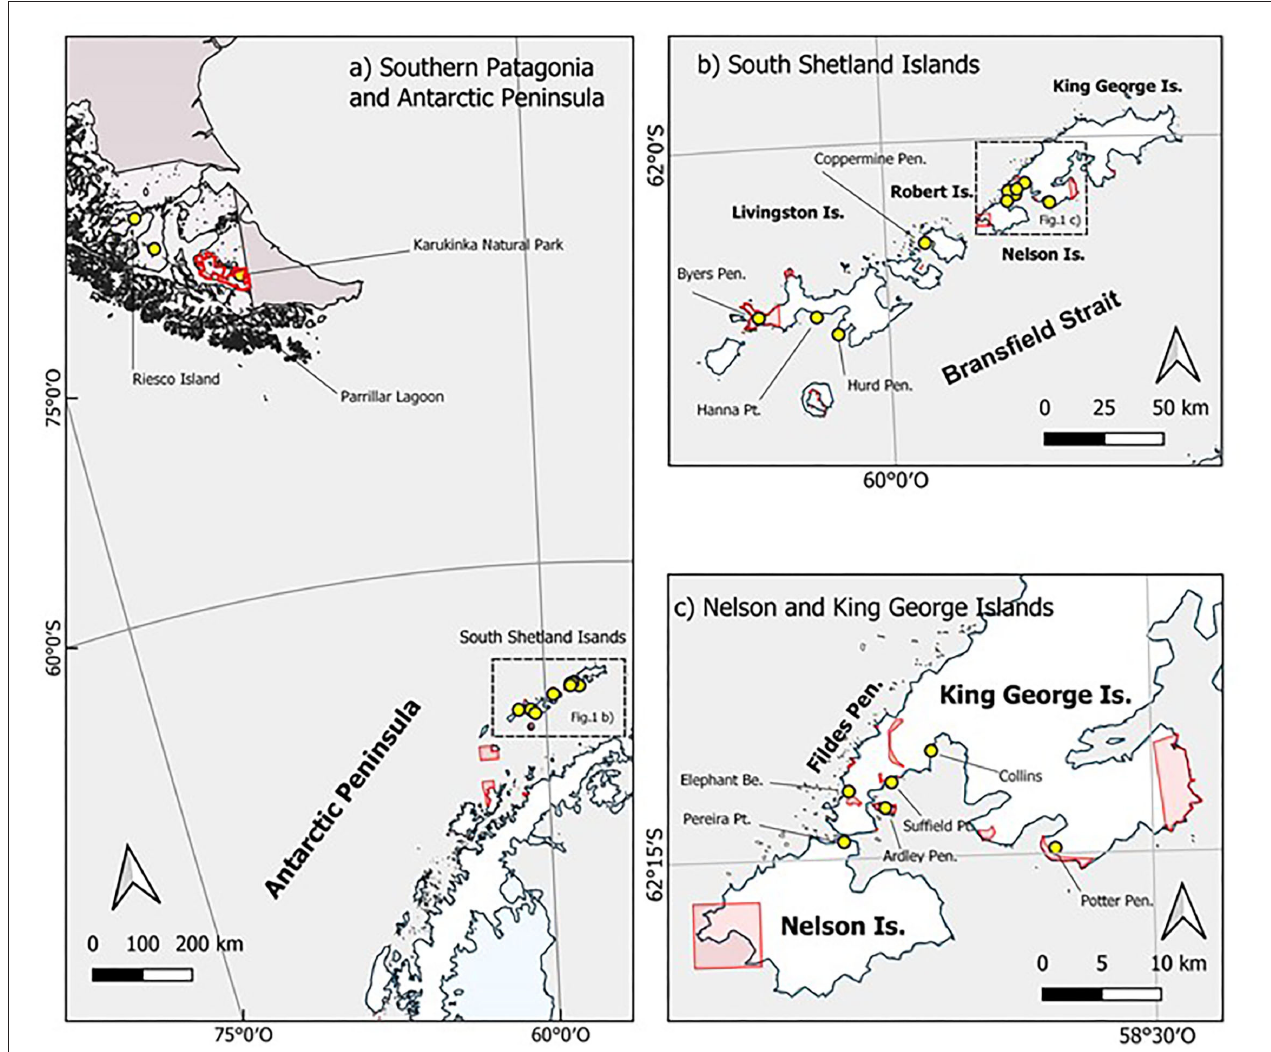
FIGURE 1 | Maps of spatial distribution and location of sampling sites in Maritime Antarctica and Southern Patagonia. Sampling sites depicted by yellow circles; Antarctic Specially Protected Areas (ASPAs) and protected areas in southern Patagonia in red. Map (a) Southern Patagonia and Antarctic Peninsula: A general map of sampled populations from sites at Riesco Island, Parrillar Lagoon, and Karukinka Natural Park in Southern Patagonia and Tierra del Fuego Island and the group of sampling sites located along South Shetland Islands. Map (b) South Shetlands Islands: A detailed location map of sampling sites at Byers Peninsula, Hanna Point, and Hurd Peninsula on Livingston Island; Coppermine Peninsula at Robert Island; and the group of sites located on King George and Nelson Islands. Map (c) Nelson and King George Islands: An inset detail of sampling sites at Elephant Beach, Ardley Peninsula, Suffield Point, Collins, and Potter Peninsula on King George Island; and Pereira Point at Nelson